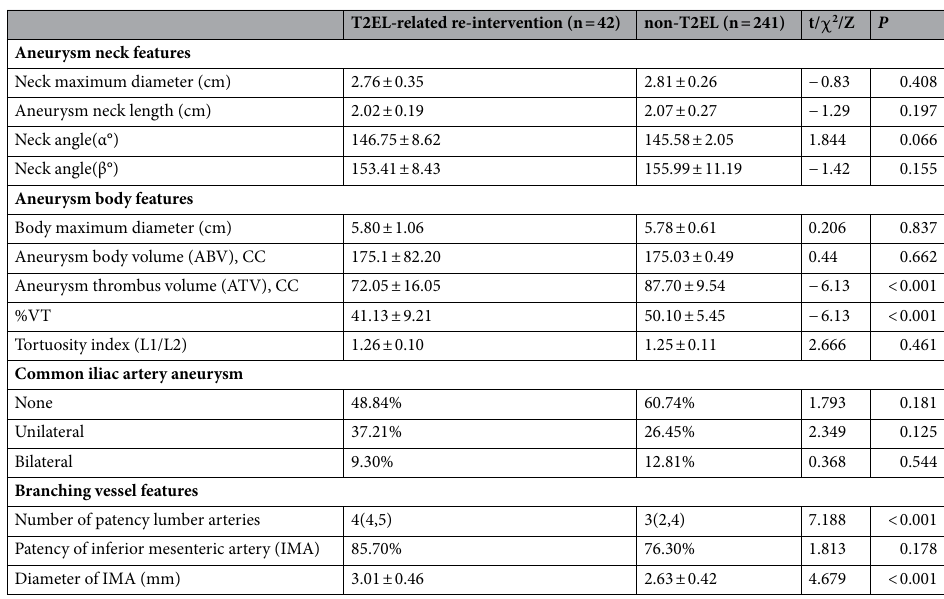
Table 2. Abdominal aortic aneurysm (AAA) morphological features. %VT =